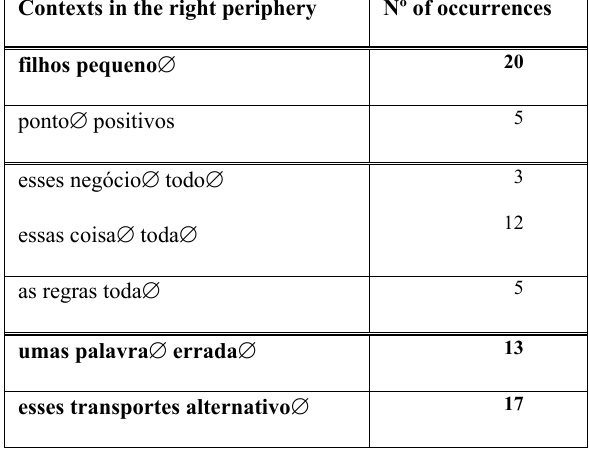
Table 4: Patterns of defective number agreement patterns in NP in Nova Iguaçu Contexts in the right periphery Nº of